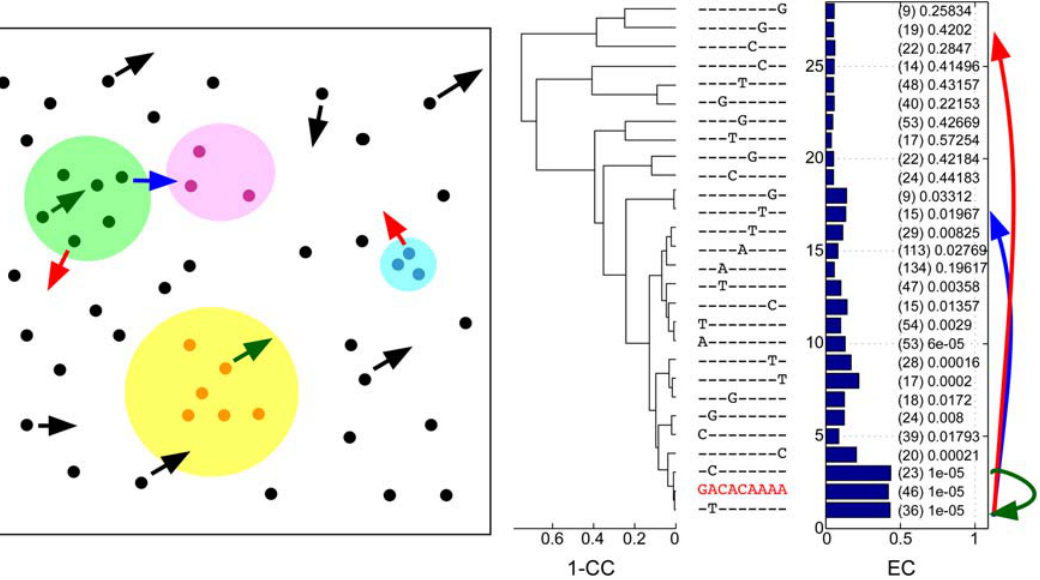
Figure 1. Possible outcomes of binding site substitutions. Left panel: points represent promoter elements, discs represent TF recognition ranges. Points included within a disc represent promoter elements that are bound by the corresponding TF. Arrows illustrate the result of single nucleotide substitutions within a promoter element. Three scenarios are illustrated: binding site loss (red arrows), reduced affinity to the same TF (green arrows), or binding site switching – creation of a binding site with as higher affinity to a different TF (blue arrows). Right panel: Our motif landscape analysis tool [17] is used to detect these three scenarios. This display captures the effects of motif single nucleotide substitutions on the expression profiles of the downstream genes. The analyzed motif is the yeast Ndt80 sporulation factor (consensus marked in red). The dendrogram on the left part of the display shows the similarity in mean expression profiles between gene sets bearing variations of the motif in their promoters. The right side of the display shows the similarity within sets of genes that contain the same motif variation in their promoters, as measured by the EC score. Gene set sizes appear in parentheses, and p-values corresponding to the EC scores follow. The middle section displays the sequence of the motif variation examined in the corresponding row (with a ‘-’ indicating same nucleotide as the wild type motif). A substitution that is in the recognition range of the same TF is expected to maintain a high EC score and a similar expression profile (green arrow). A substitution that causes binding site loss is expected to be recognized by both loss of coherence and a change in the mean expression profile (red arrow). A substitution that creates a motif that is in the recognition range of a different TF is expected to maintain high expression coherence, while altering the mean expression profile (blue